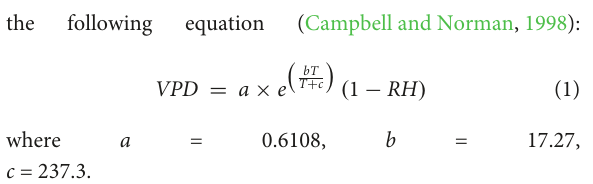
0.27 µ m thermal expansion coefficients of < 0.1 µ